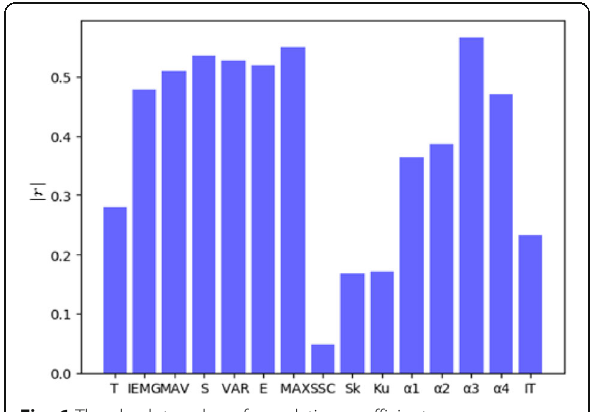
Fig. 6 The absolute value of correlation